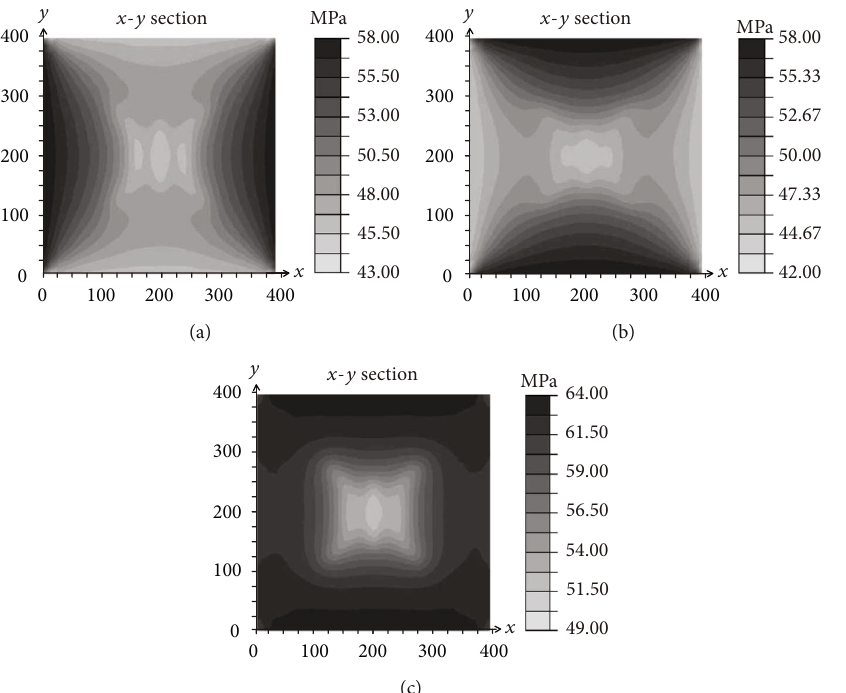
Figure 17: (a), (b), and (c) present the σ the in fl uence of natural fractures.